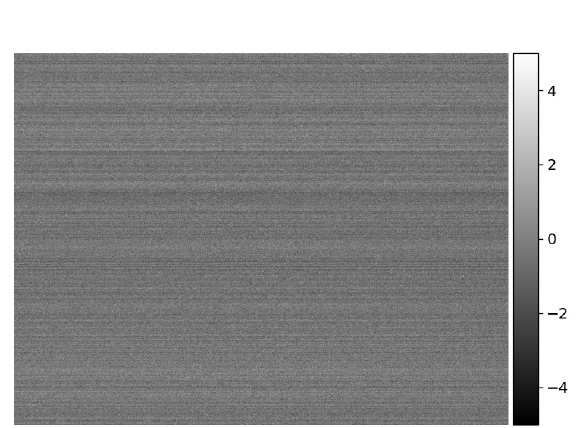
Figure 9. Dark subtraction result of a dark image measured at t = 0 . 1 s and T = 48 ◦ C